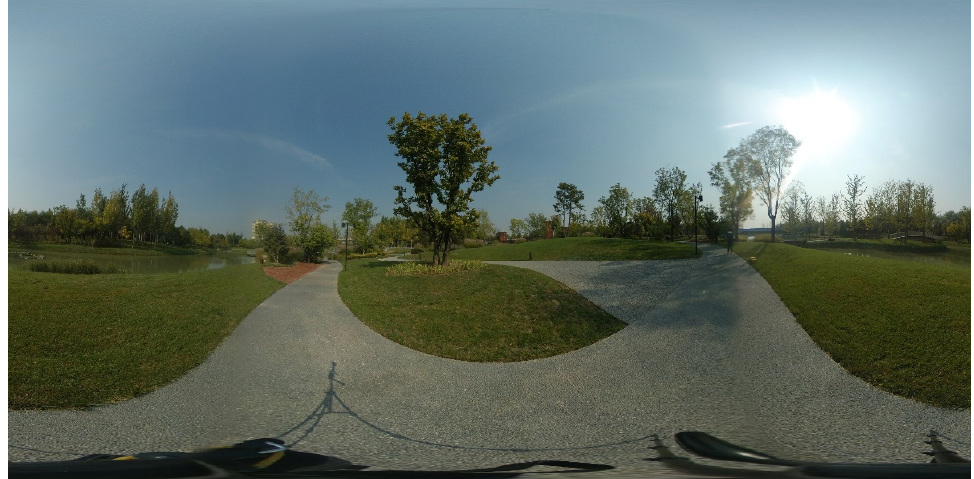
Figure 1. The panoramic view of an urban green